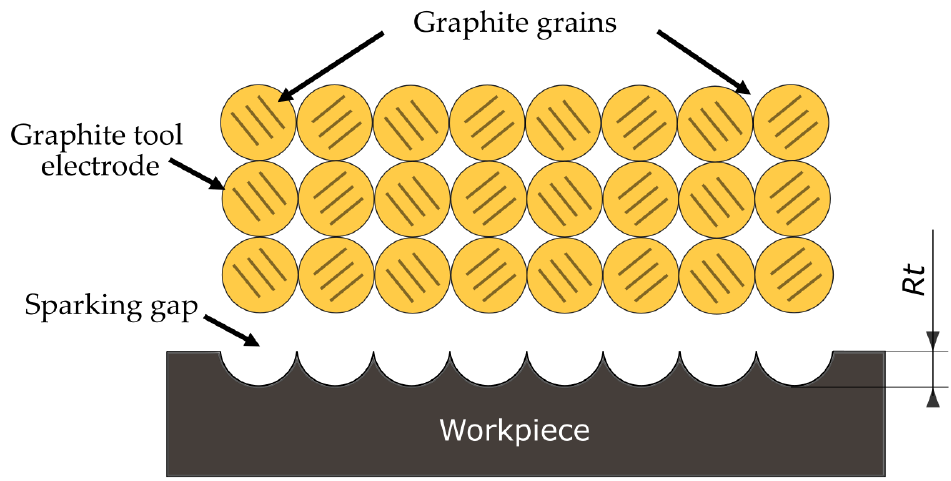
Figure 5. Illustration of mapping microstructure of graphite grains on surface of workpiece.